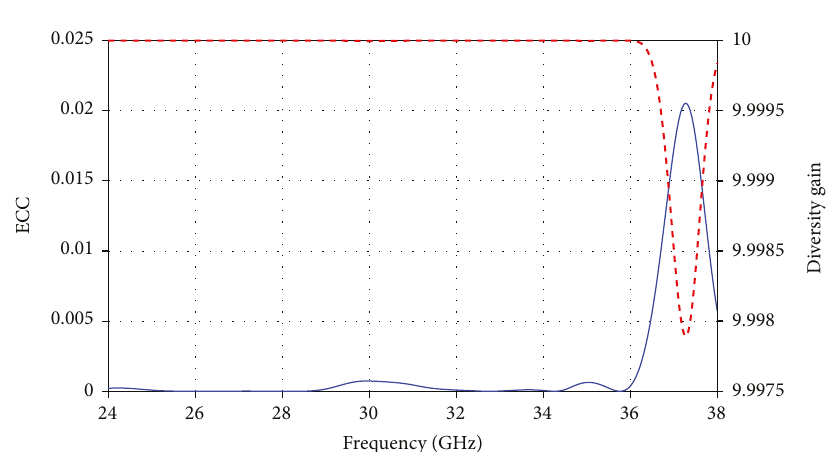
Figure 12: Correlation coe ffi cient and diversity gain of the proposed UWB MIMO antenna.